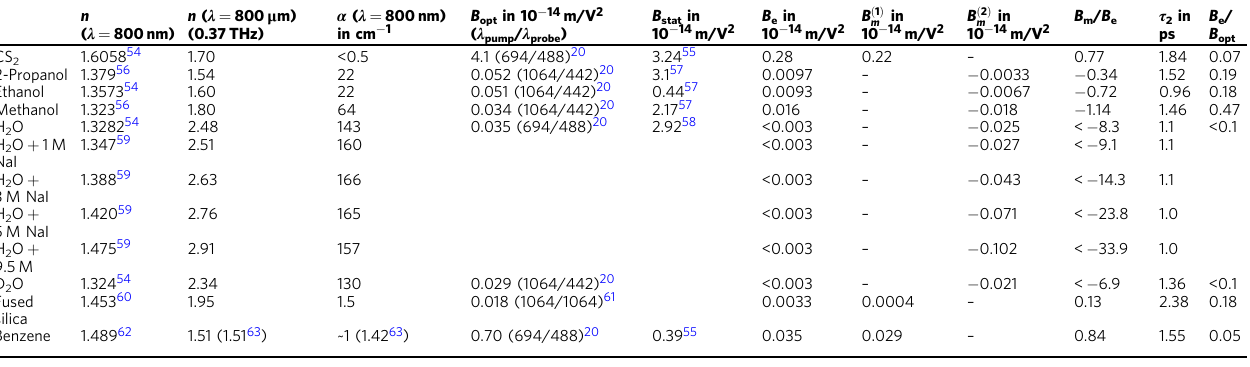
Table 1 Summary of literature and experimental parameters relevant to this study n n ( λ = 800 μ m) ( λ = 800nm)